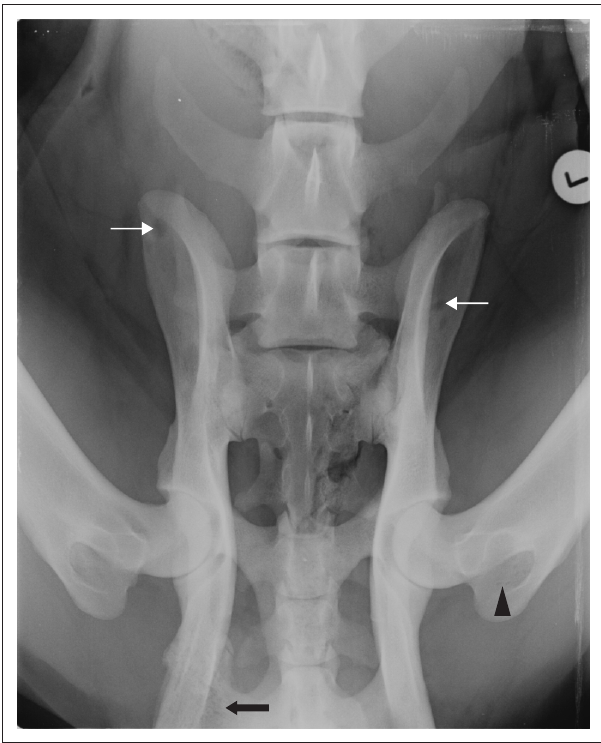
Black block arrow, in the right tabula ossis ischia. White arrows, two smaller lytic foci in the left ilial wing. FIGURE 2: Ventrodorsal flexed view of the pelvis showing one well marginated lytic focus in the right ilial wing.